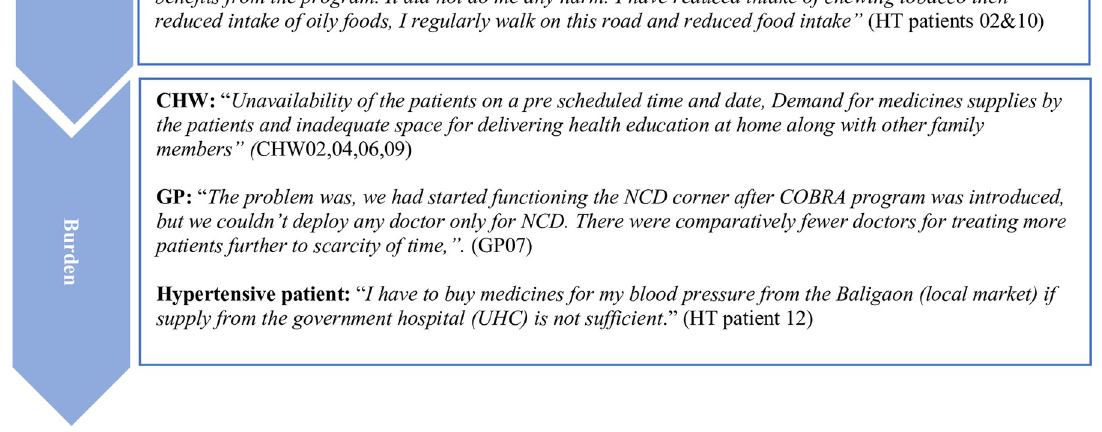
Fig 1. Illustrative quotes from Bangladesh participants.